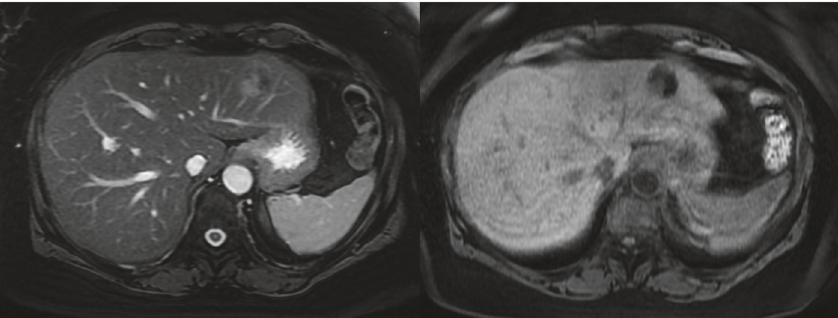
Figure 1: MRI . FIESTA (right) and T1-weighted images (left) revealed a 3.1 x 3.4 x 2 cm mass in the left lateral lobe of the liver. The lesion is hypervascular with washout of contrast on delayed post-contrast enhanced sequences.